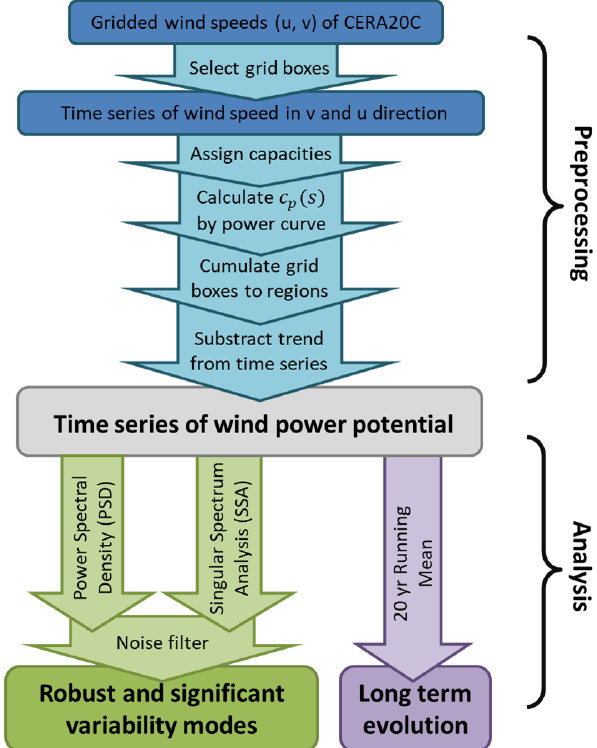
Figure 1. Flow chart of the main parts of the data processing. In the upper part the prepossessing from ECMWF product to wind power potential time series is shown (blue), in the lower part the different analysis tools and their products are shown (green and